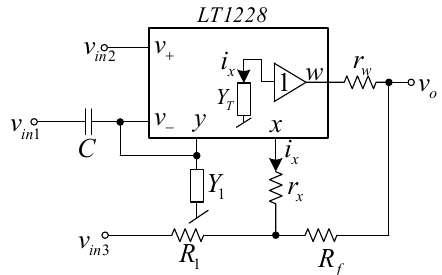
Figure 5. Proposed filter with parasitic elements.